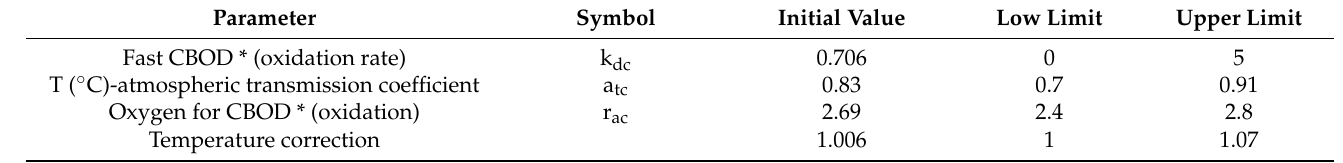
Table 3. Initial and upper and lower parameter values in the QUAL2KW